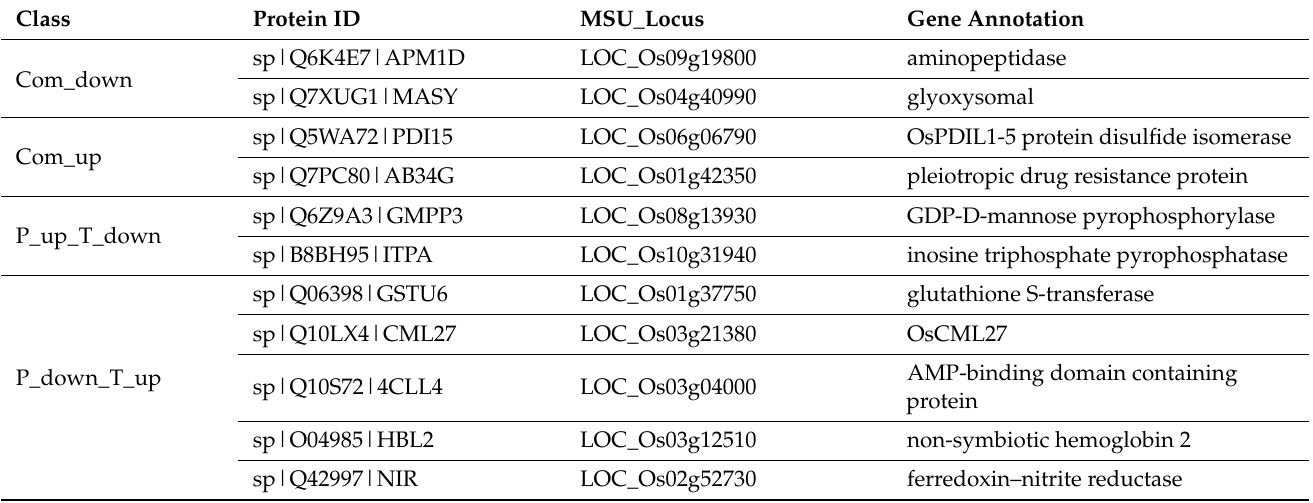
Figure 4. N-deficiency responses in transcriptome profiling in LY9348 roots. ( A ) Volcano plot of DEGs; ( B ) KEEG pathway of DEGs identified in LY9348 roots. The pathway names are provided in the vertical axis, rich factor in the horizontal axis, the size of the point represents the number of DEGs, and the color of the dot represents the q value; ( C ) quantitative real-time PCR (qRT-PCR) confirmation of selected genes. The expression level of each gene was normalized by using a reference gene OsActin and then calculated as relative expression level between 1/4N and 1N (control). Bars represent mean log 2 fold change. KEGG: Kyoto Encyclopedia of Genes and Genomes; DEGs: different expression genes. Table 1. The part of gene list for correlation analysis of transcriptome and